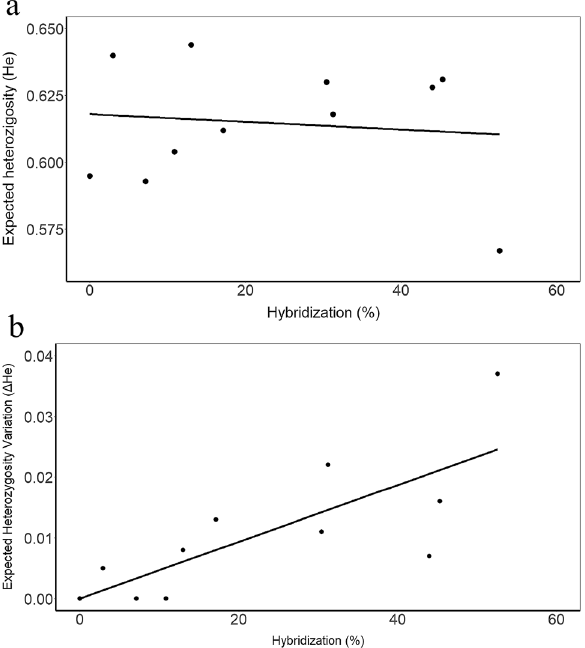
Figure 3. Linear regressions between ( a ) genetic diversity ( H E ) or ( b ) variation in genetic diversity (Δ H E ) and the percentage of hybrids observed in each population. Genetic diversity does not decrease significantly as the percentage of hybrids rises (r 2 = 0.012, p = 0.741), but when the percentage of hybrids increases, the variation in genetic diversity increases as well (r 2 = 0.593, p =